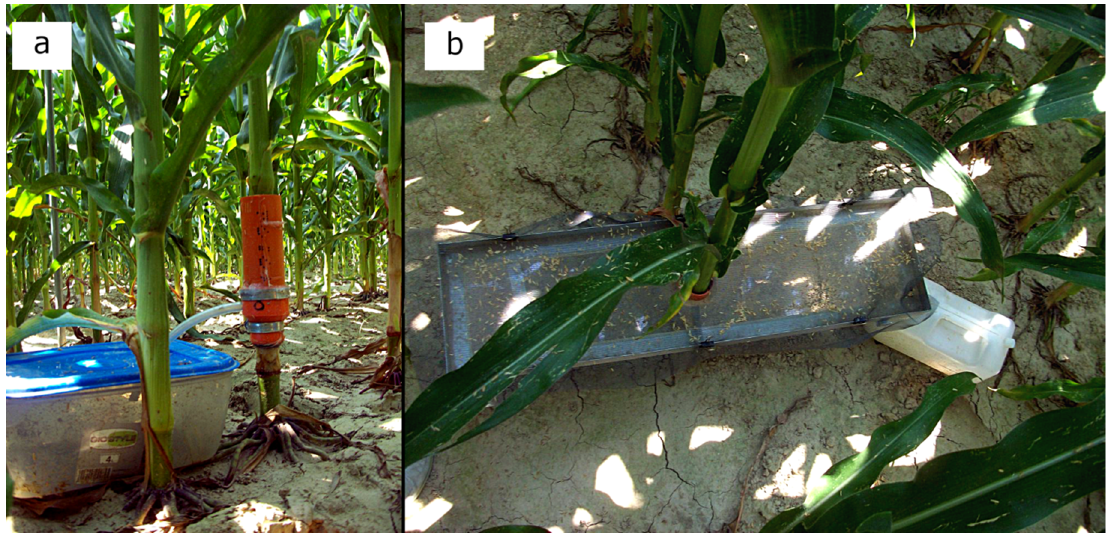
Figure 3. Stemflow ( a ) and throughfall ( b ) collectors at the study